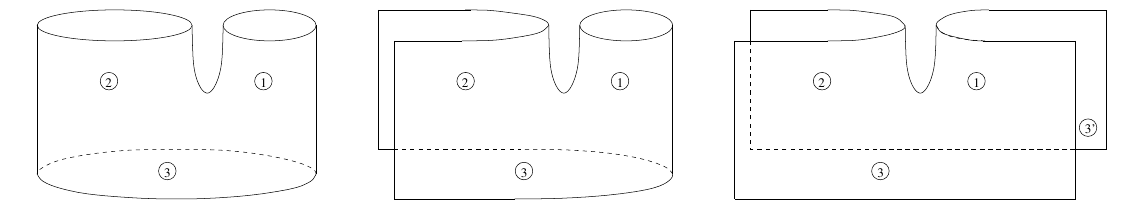
Figure 1 . Splitting of a big string into two smaller ones and its decompacti(cid:12)ed